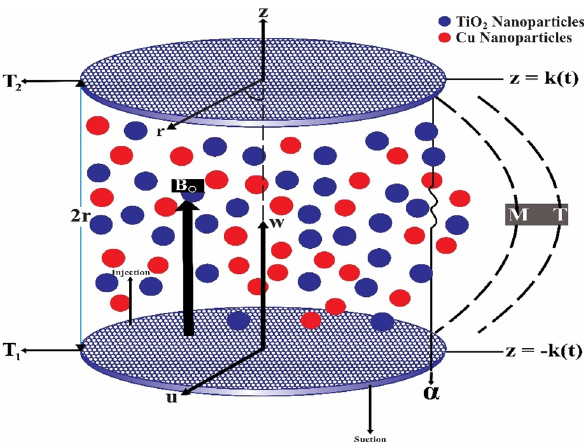
Figure 1. Physical